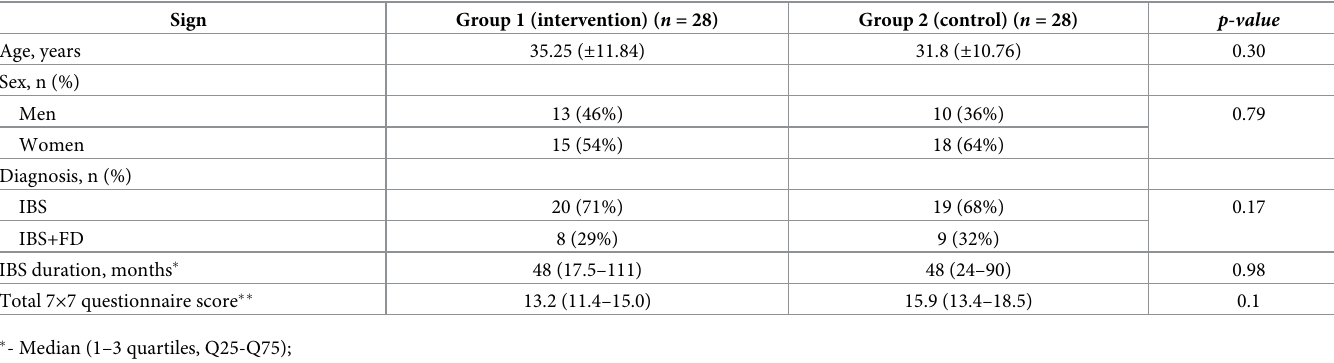
Table 3. Comparison of patients in groups 1 and 2 by sex, age, and disease duration.